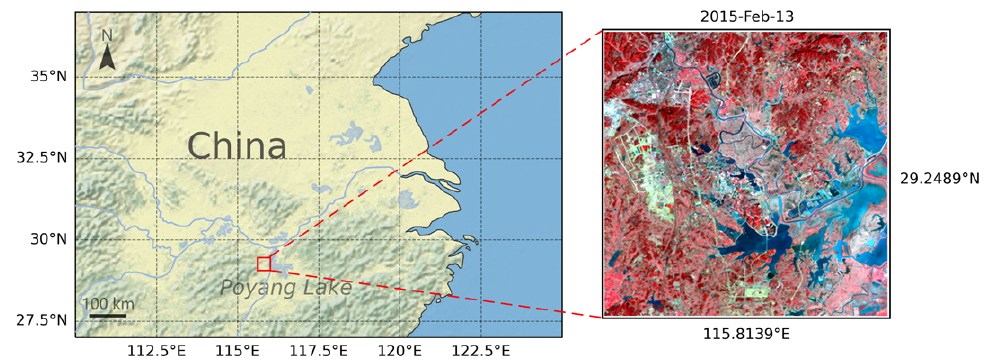
Figure 7. Study area location and overview of the Poyang Lake dataset. The Landsat image uses a false color combination of near-infrared, red, and green